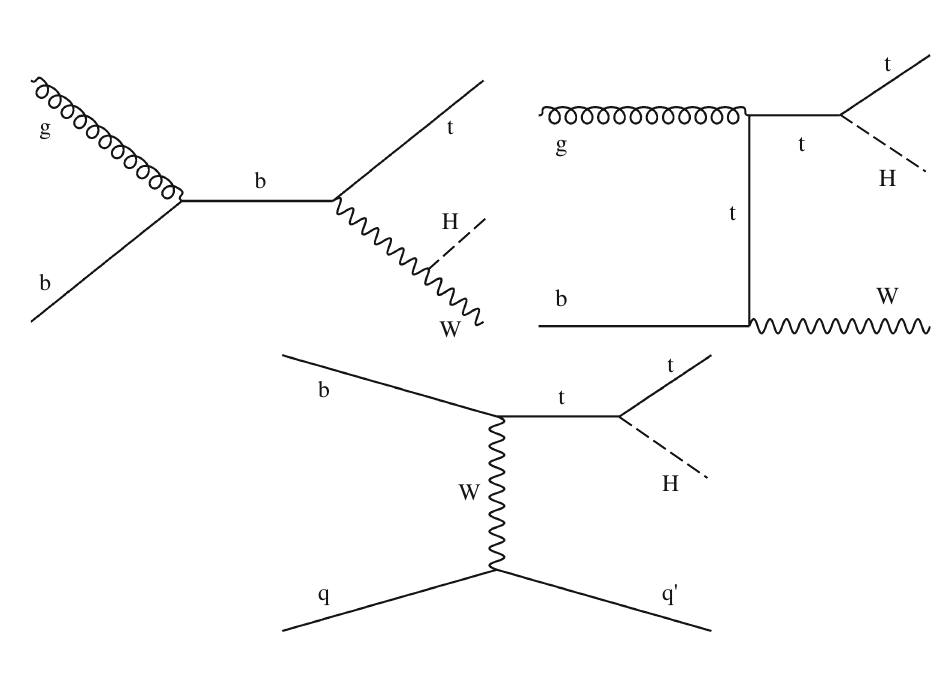
Fig. 3 Examples of leading-order Feynman diagrams for the gg → ZH production mode